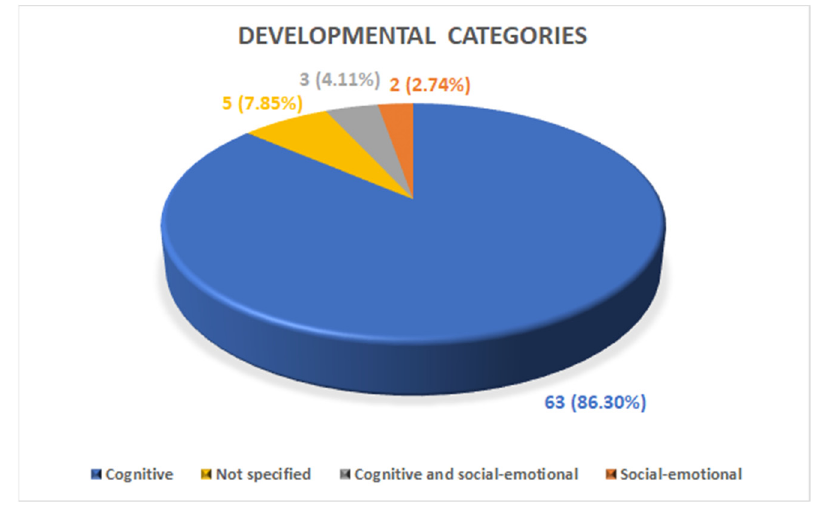
Figure 4. Empirical studies: developmental categories.